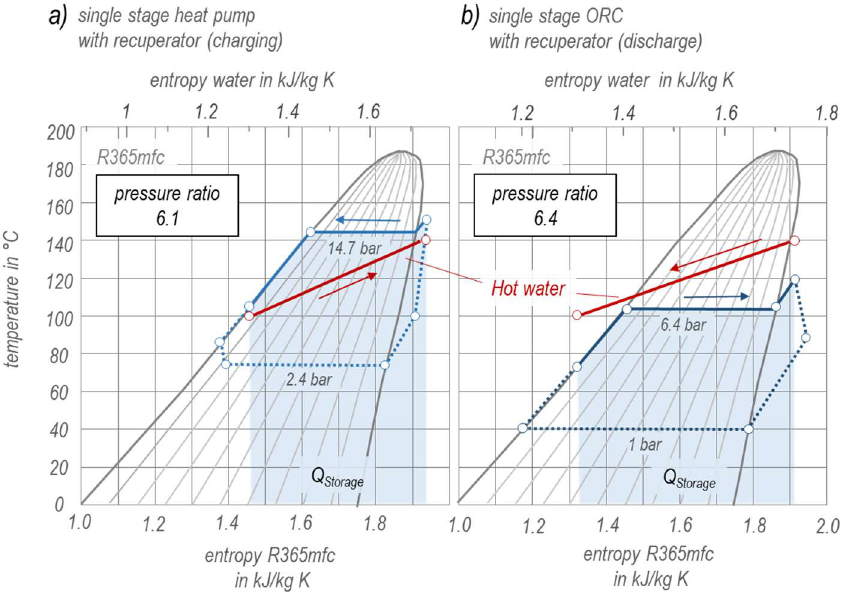
Figure 6. t,s diagram of the optimum single stage heat pump ( a ) and ORC process ( b ) with hot water storage temperature spread of 140 °C/100 °C (R365mfc, isentropic efficiencies of compressors and expanders 70%, waste heat temperature 90 °C, ambient/ORCs condenser temperature 40 °C, terminal temperatures at the pinch points 5 K).